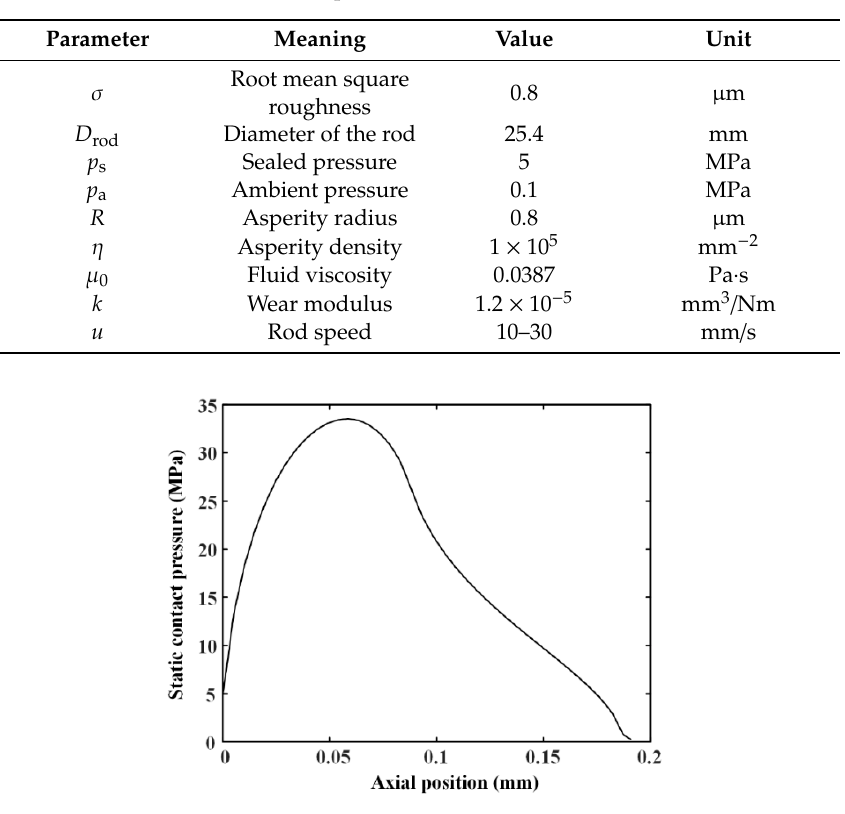
Table 2. Main parameters in the simulations.